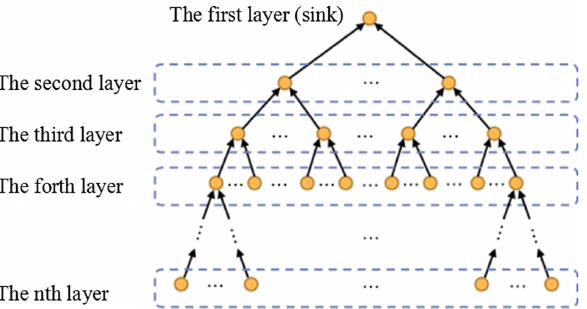
Figure 12. DEDST: THECB can convert the WSNs to a Distance, Energy, and Discharge level Search Tree (DEDST). The first layer of the tree is the sink node. The last n -hop nodes of the sink are classified into the n th